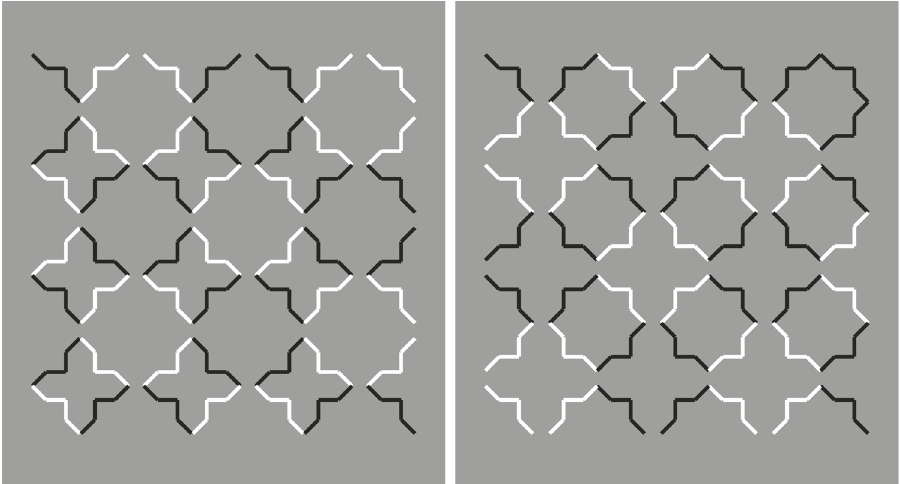
Figure 5. Similarity by contrast polarity pitted against closure and proximity principles.